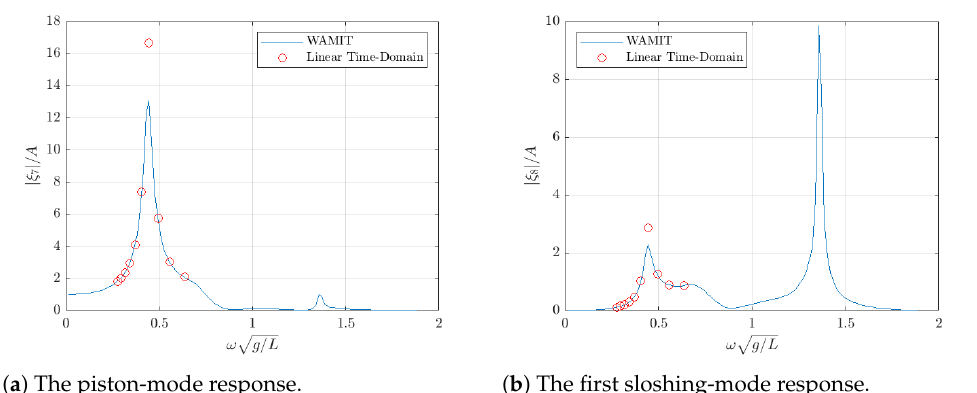
Figure 16. Comparison between the time- and frequency-domain free response of the